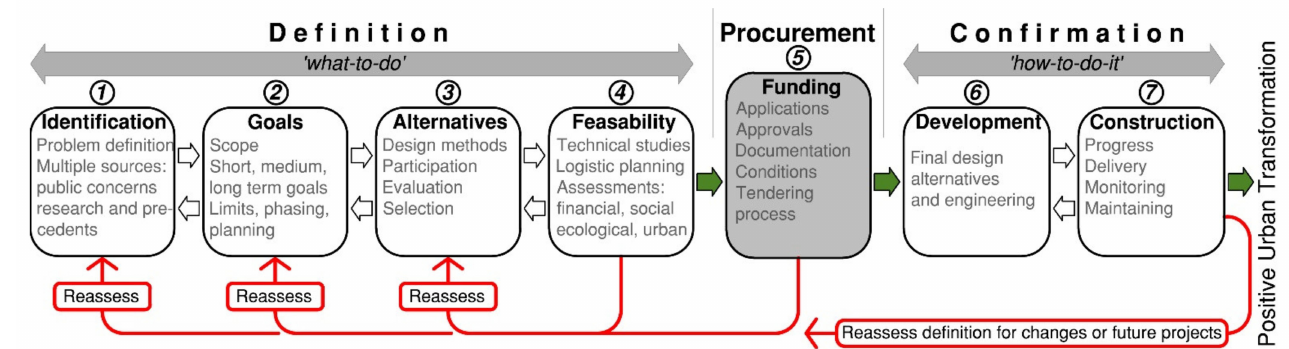
Figure 4. The integrated model was employed, placing particular emphasis on the definition.